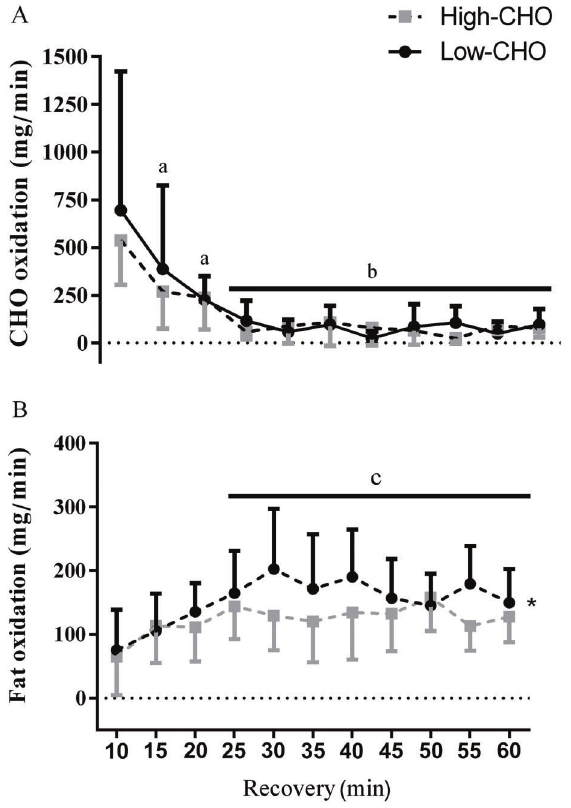
Figure 2. Carbohydrate (CHO) ( A ) and fat ( B ) oxidation rates throughout the recovery of a single, high-intensity exercise bout . ( B 95% VO 2max ) performed under low- and high-CHO availability. Data are reported as means ± SD (n=8). a P o 0.05 compared to 10 min; b P o 0.05 compared to 5, 10, and 15 min; c P o 0.05 compared to 5, 10, and 15 min; *P o 0.05 compared to high-CHO availability (ANOVA and t